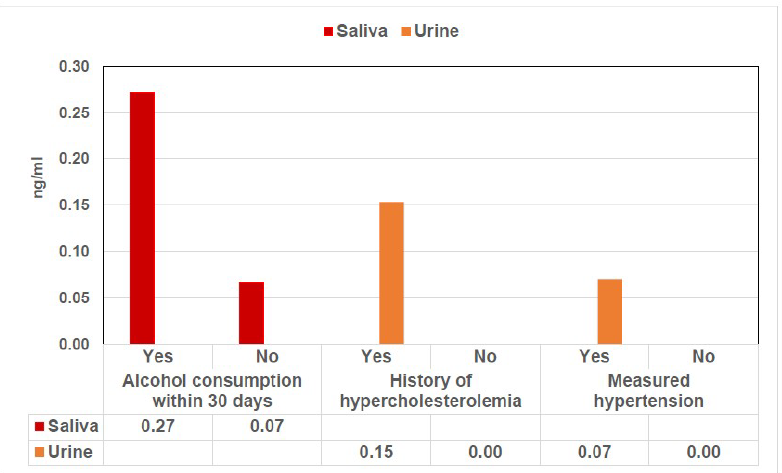
Figure 4. Elevated ( p < 0.05) microcystin/nodularin levels in saliva and urine by liver cancer risk factors. Alcohol consumption within 30 days (yes, n = 37; no, n = 23); History of hypercholesterolemia (yes, n = 3; no, n = 29); Measured hypertension: (yes, n = 13; no, n = 26).